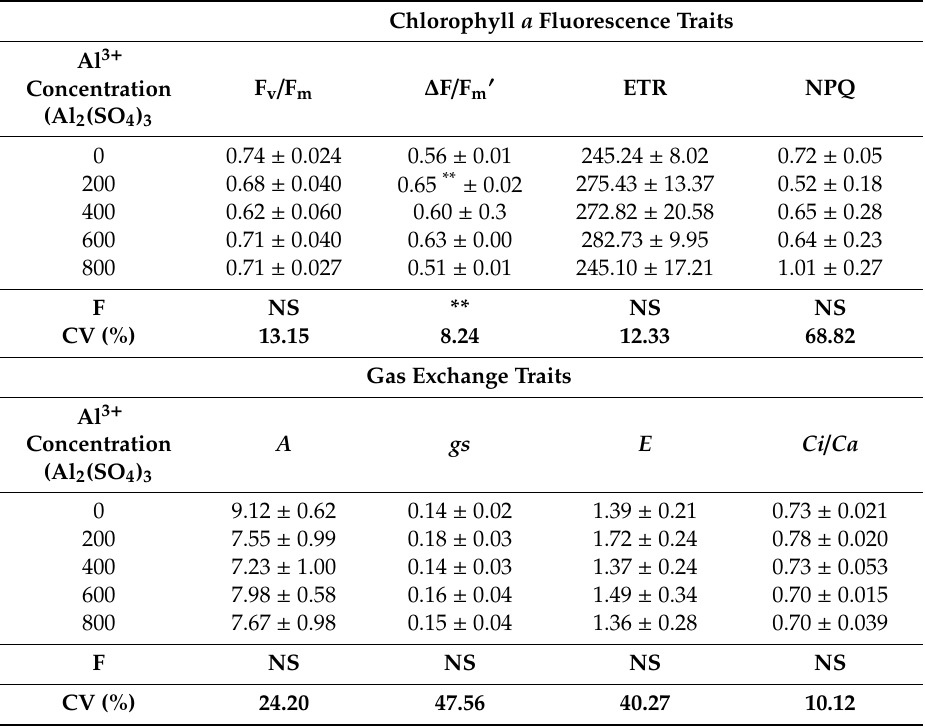
Table 3. Photosystem II (PSII) quantum potential yield (F v / F m ), e ff ective quantum yield of the PSII when reaction centers are reduced ( ∆ F / F m (cid:48) ), and non-photochemical dissipation (NPQ). Net photosynthetic rate ( A ), stomatal conductance ( g s), transpiration rate ( E ) and relation between the internal and external CO 2 concentrations ( Ci / Ca ) in Eugenia dysenterica plants, after 20 days of growth at di ff erent Al concentrations (0, 200, 400, 600 and 800 µ mol L − 1 ). Electron transport